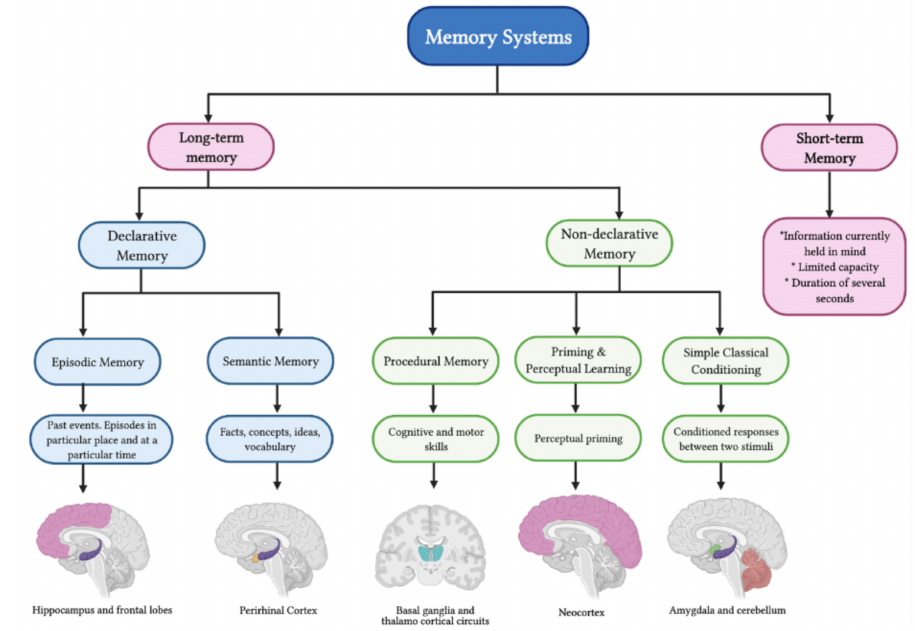
Figure 2. Types of memory and memory